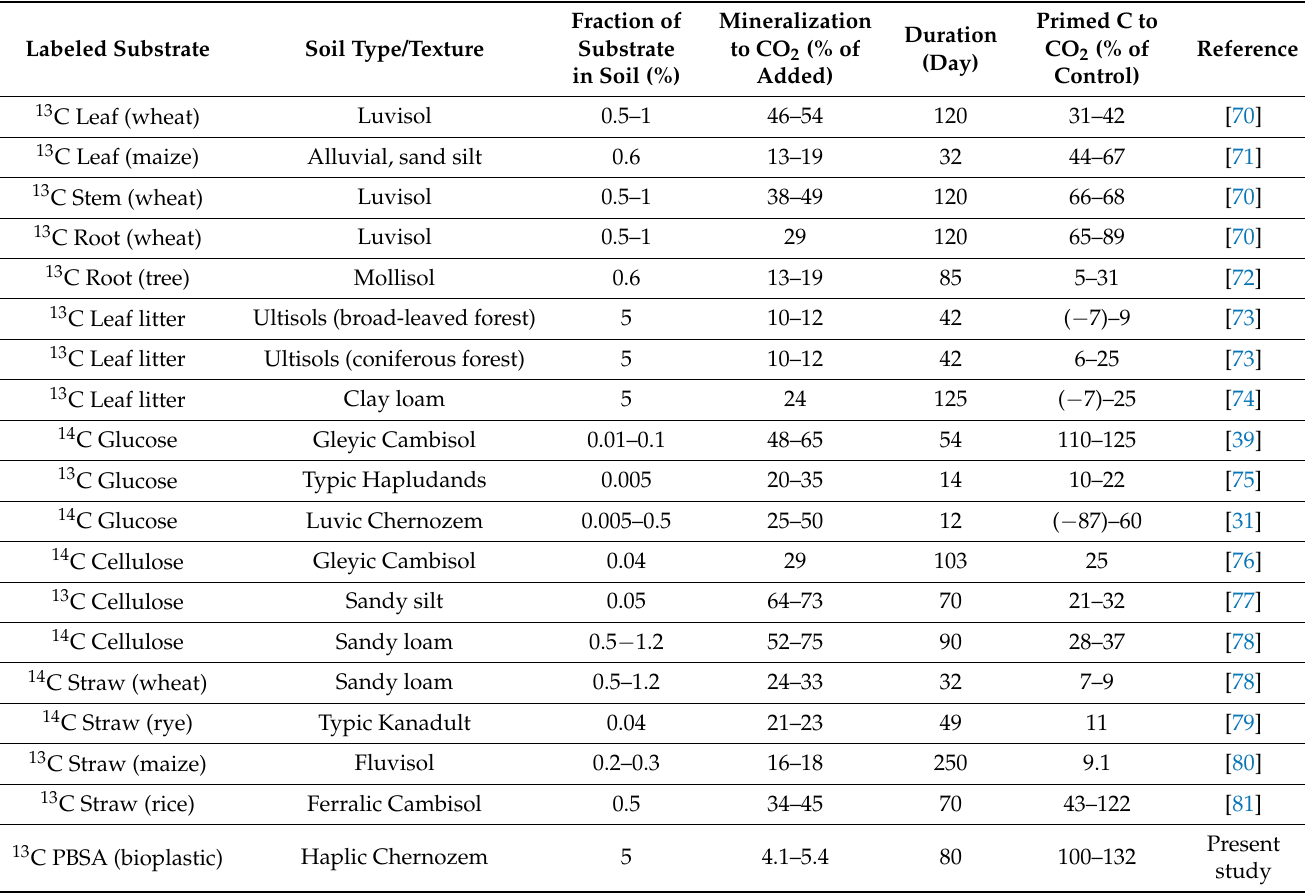
Table 1. Mineralization of different substrates in the soil environment and their effect on the soil organic matter (SOM)